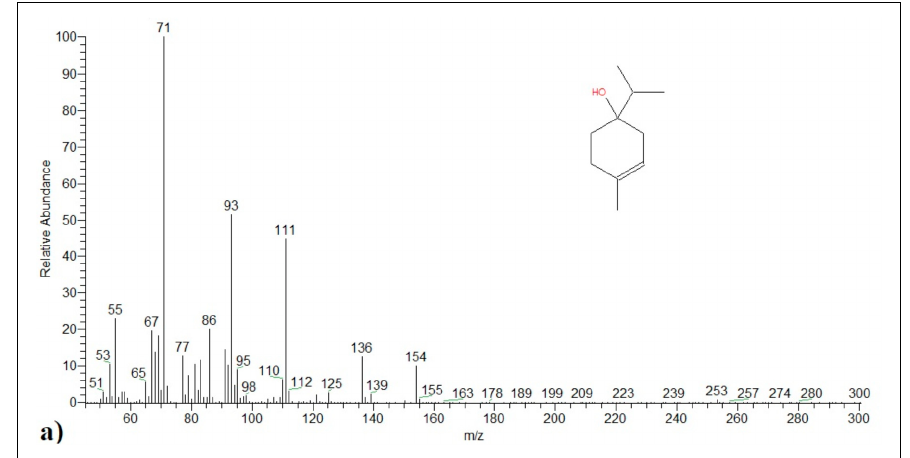
Figure 4. The 70 eV mass spectrum of D -limonene ( a ), γ -terpinene ( b ), β -pinene ( c ), and isopregol ( d ) components of Corymbia citriodora leaves’ recovery oil.